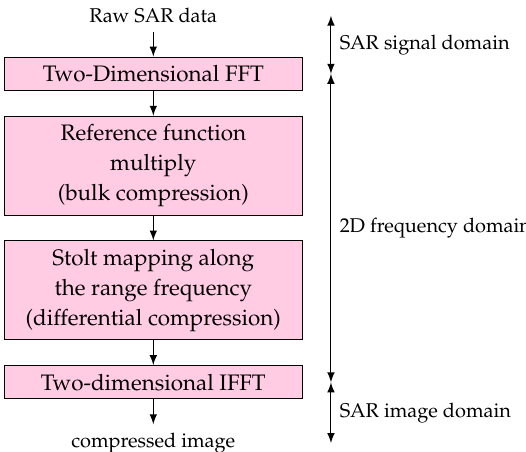
Figure 6. Block diagram of the omega-K algorithm, from